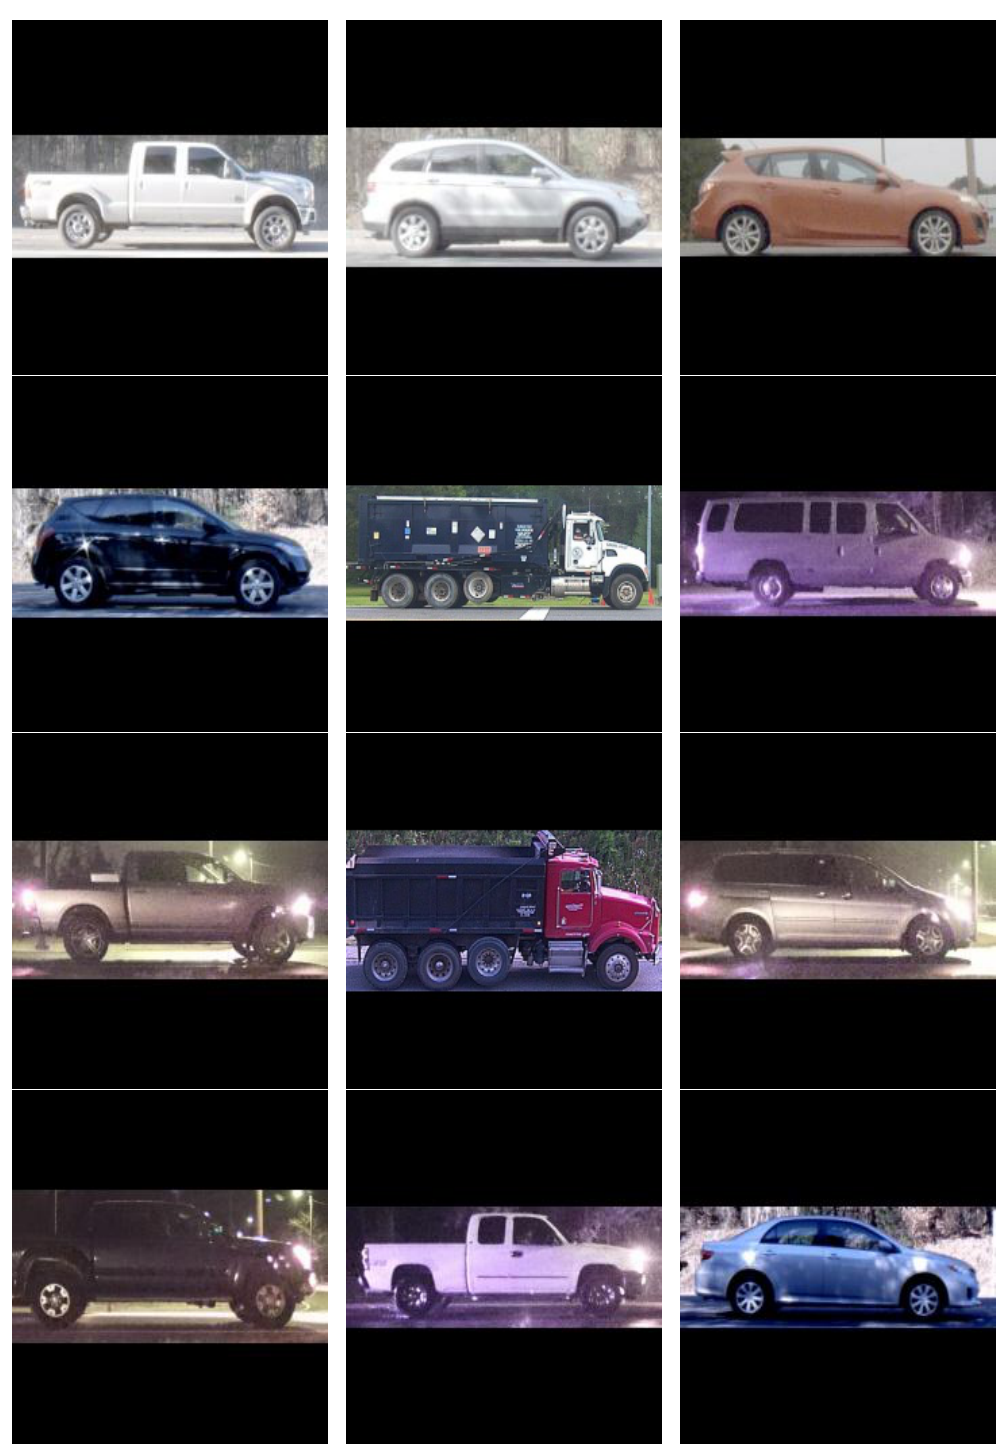
Figure 1. Sample images from the PRIMAVERA